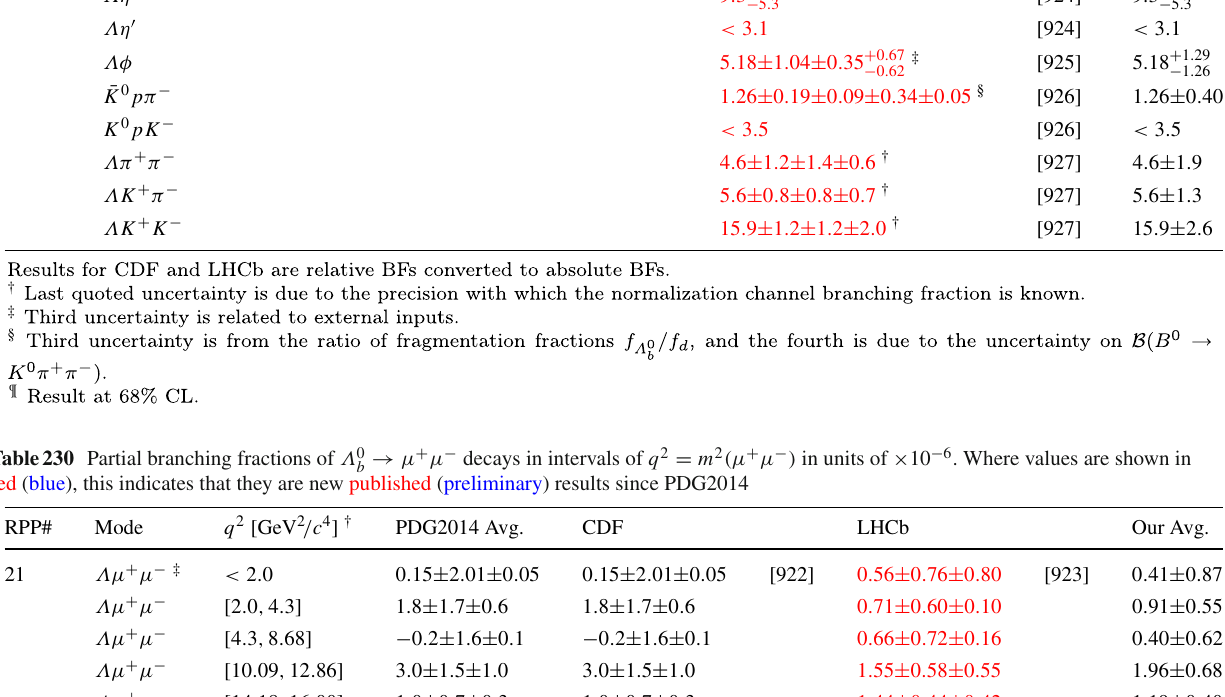
decays in units of b